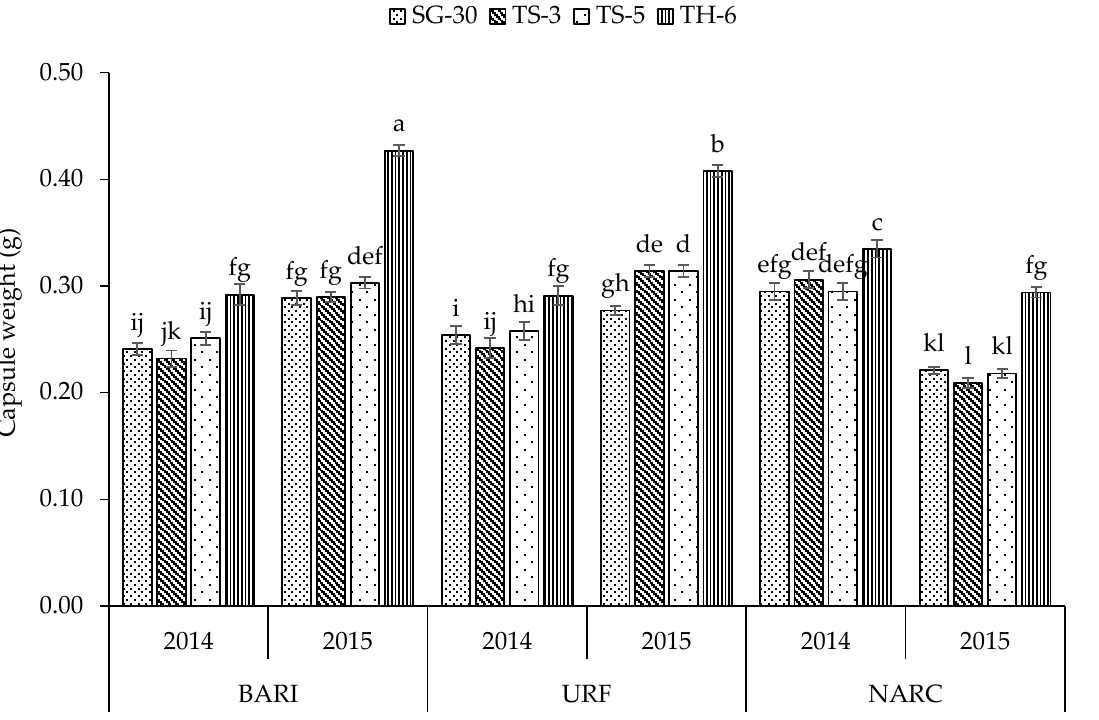
Figure 6. Capsule weight (g) of four sesame cultivars at three locations during 2014 and 2015 (pooled over micronutrients). The bars indicates standard error (±SE) of mean (n = 3). All means are significantly different at p ≤ 0.05.